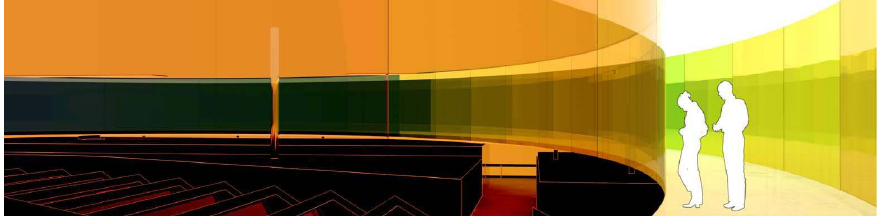
Figure 2: View of the inner appearance of the glass walls, no structural elements are in the inner and outer walls except the curved glass